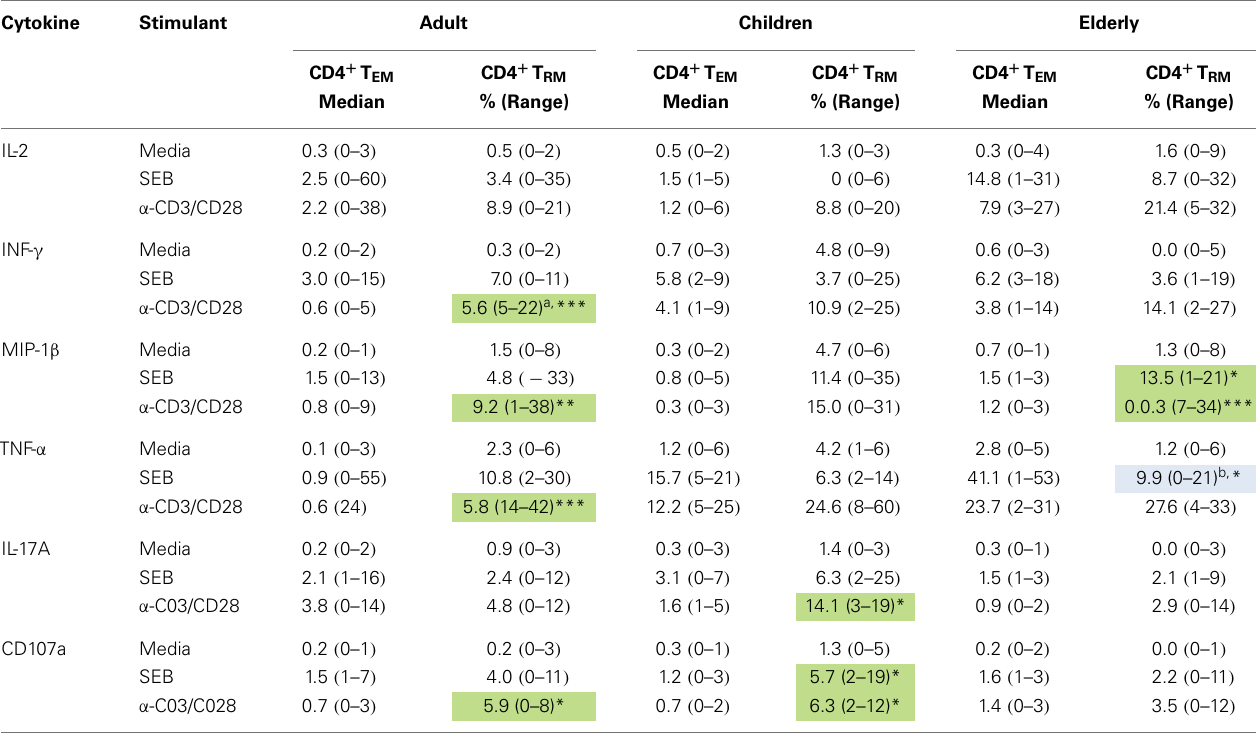
Table 2 | Comparison of PBMC CD4 + T EM and gastric CD4 + T RM cells activation responses in adult, children, and the elderly .